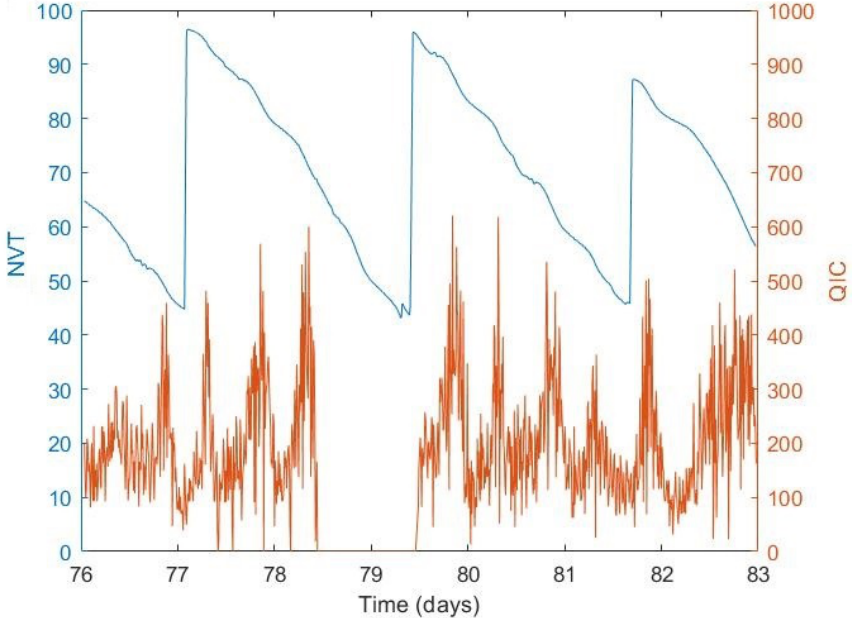
Figure 4. LNG(Liquefied Natural Gas) level in storage tank (NVT) in blue, and gas consumption (QIC) in